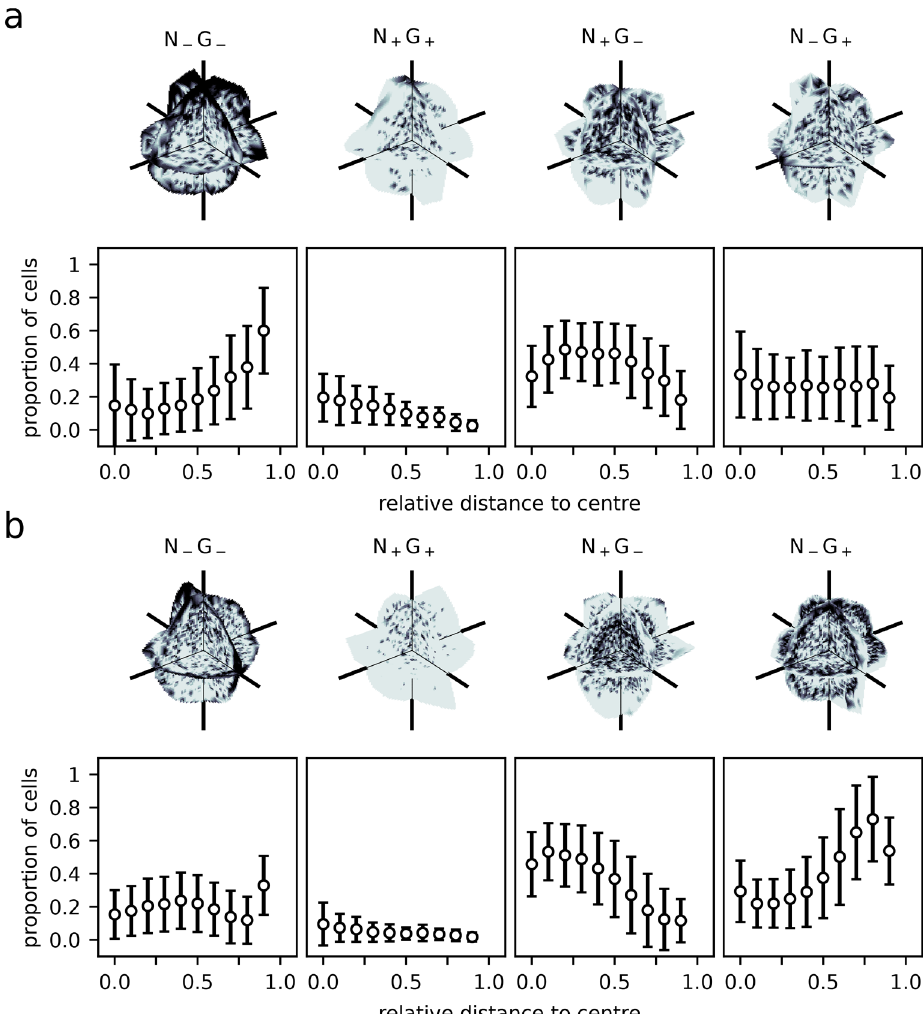
Figure 4. Expression type cluster analysis for ICM organoids. ( a ) 24 h old ICM organoids; ( b ) 48 h old ICM organoids. Black indicates the presence of an expression type, white indicates its absence, respectively. Shown are slices through the ICM organoids at cartesian origin. Expression type compositions in dependence of the relative distance to the ICM organoid centre. Cells are sorted according to their distance to the ICM organoid centre of mass and binned into 10 groups. Points indicate the average proportion of a cell fate type for the 10 bins, the bars denote the standard